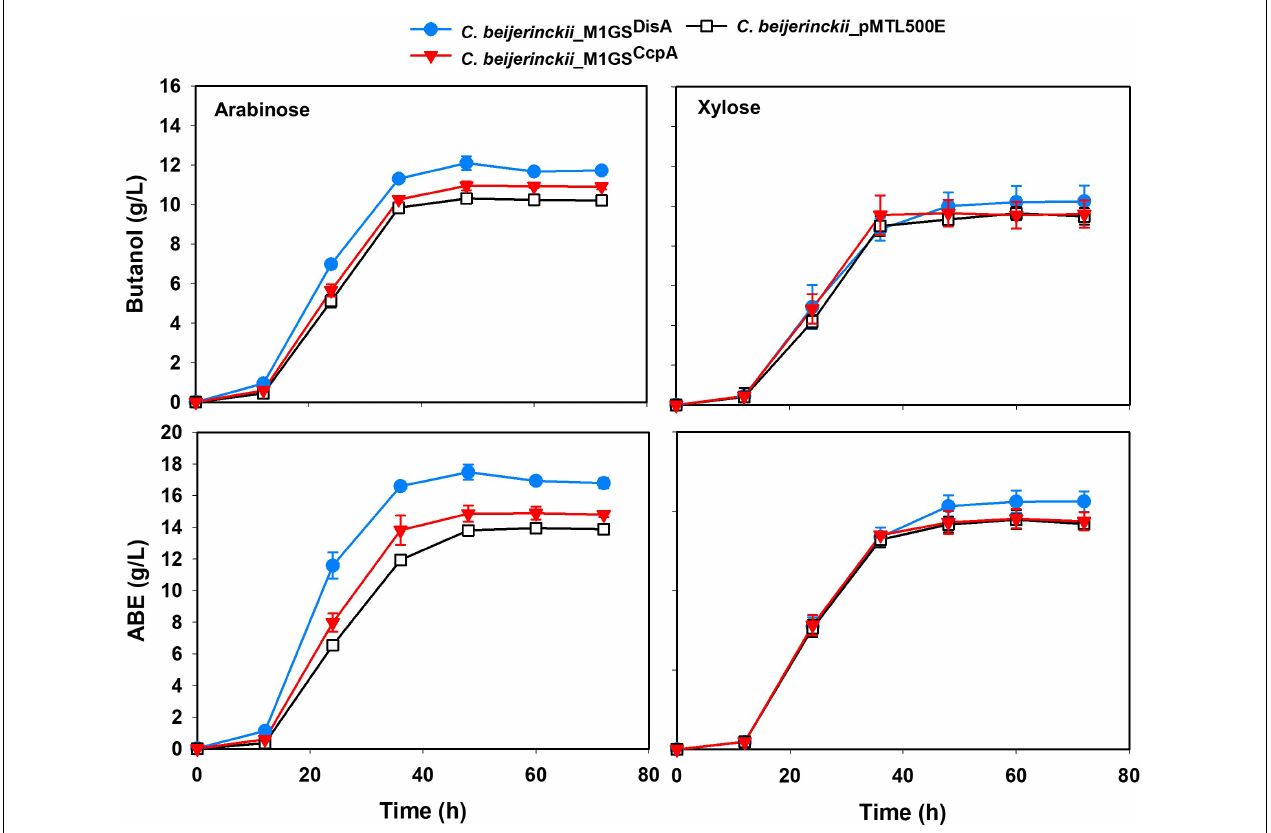
FIGURE 4 | Butanol and ABE titers during a 72-h fermentation in cultures of C. beijerinckii _ pMTL500E, _M1GS CcpA , and _M1GS DisA grown on arabinose and xylose. Error bars represent standard deviation of the mean ( n =